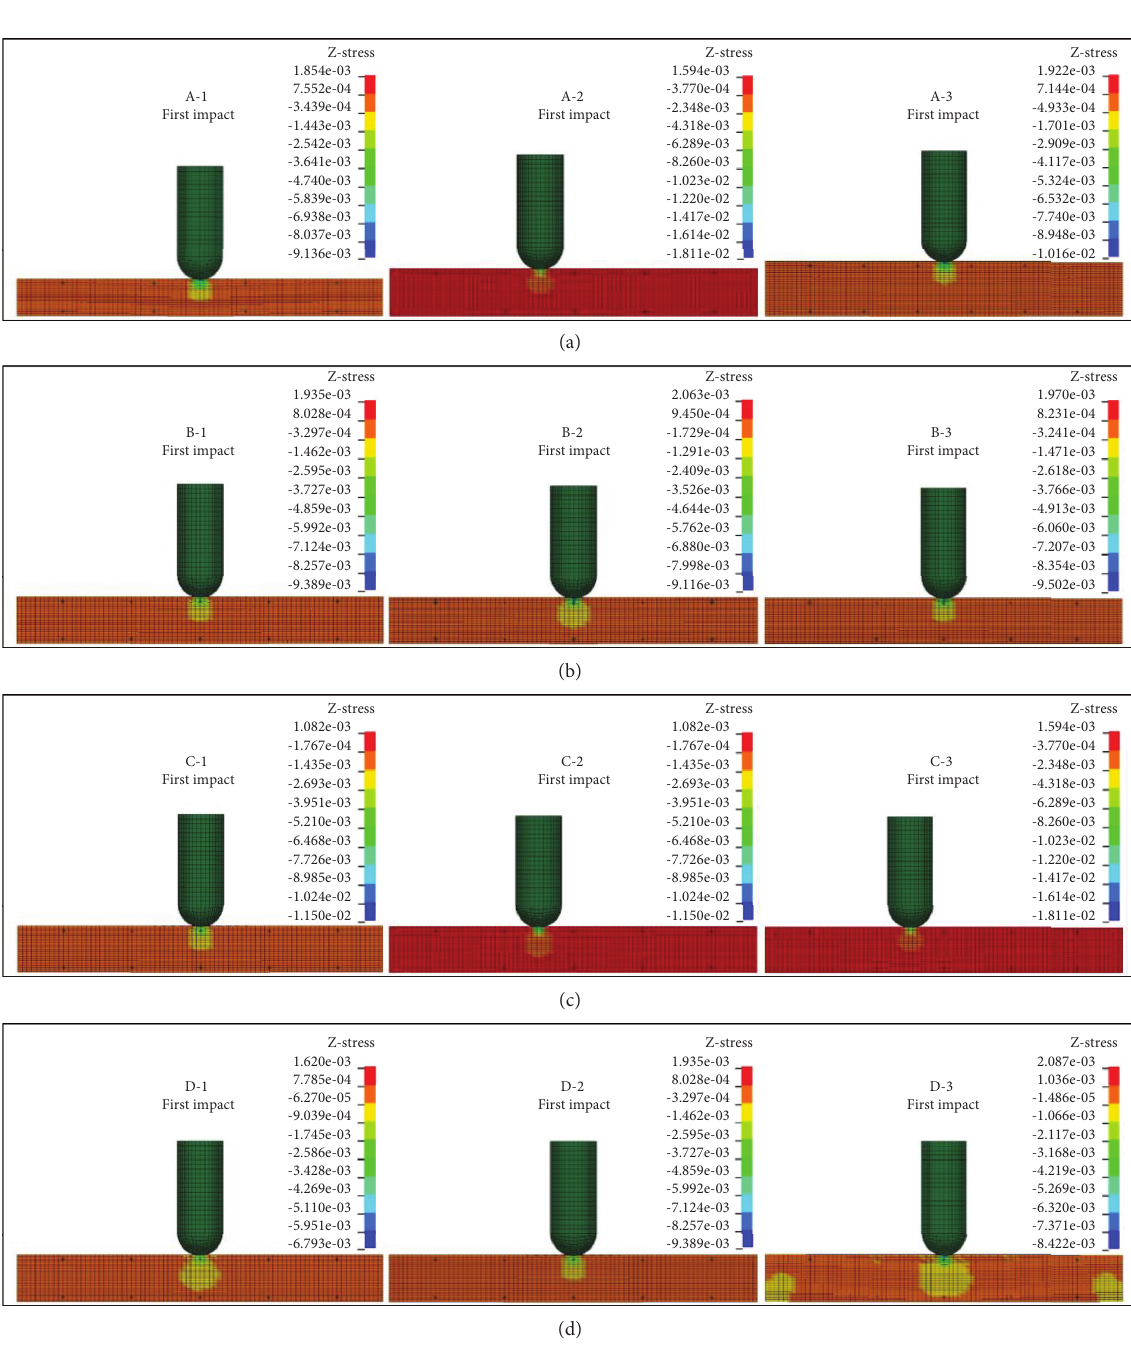
Figure 12: Vertical stress cloud for the RC slab under the first